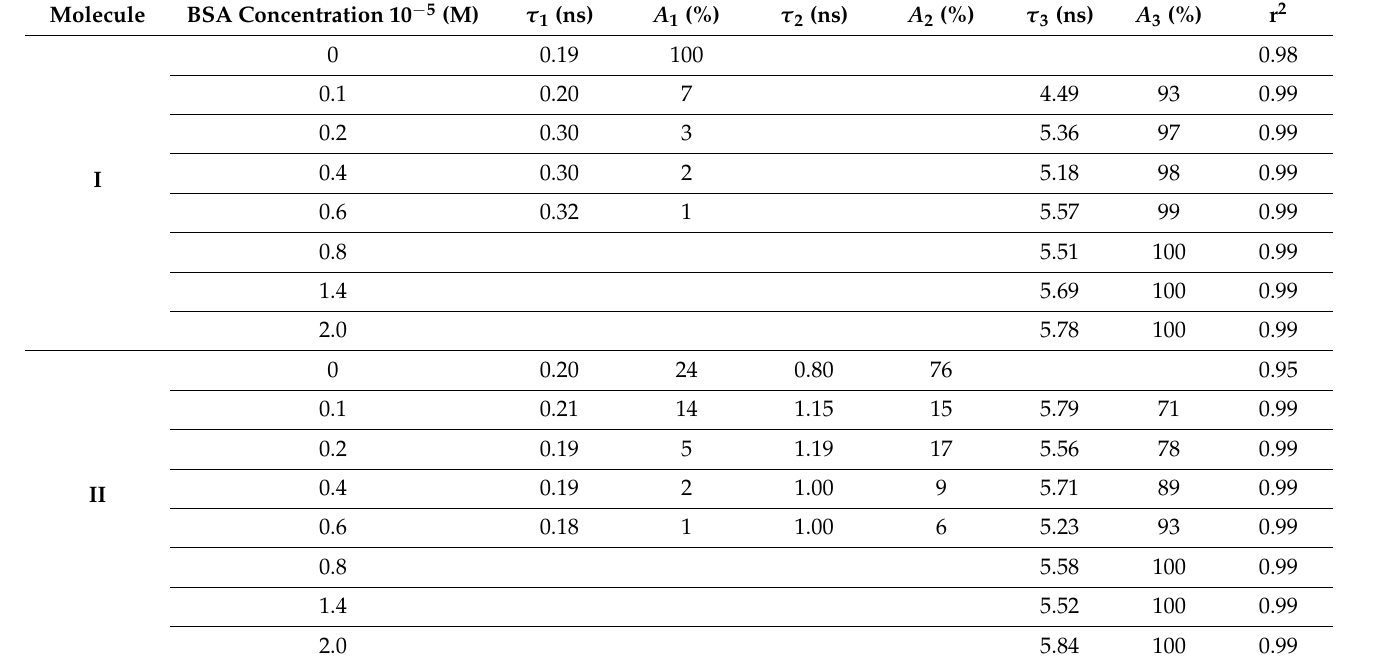
Table 1. Fluorescence lifetimes of I and II in phosphate buffer solutions containing different concentrations of BSA.